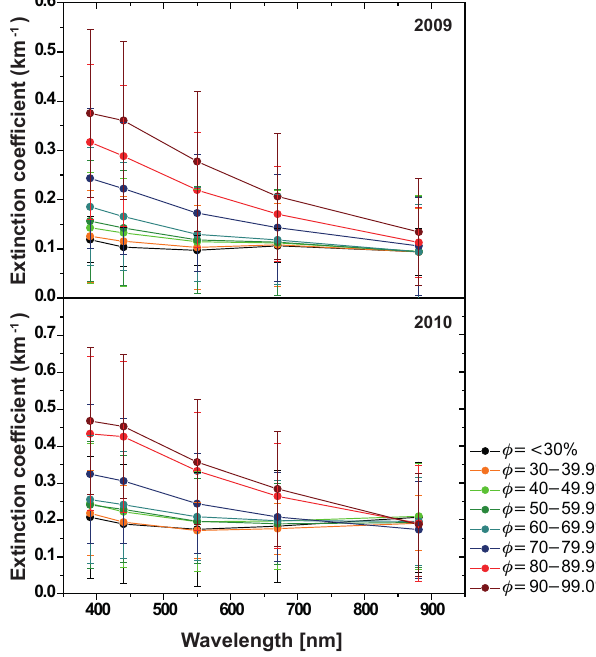
Figure 12. The mean extinction coefficient spectrum for eight rel- ative humidity classes (indicated by different colors) for the years 2009 (top) and 2010 (bottom). Vertical bars indicate the SD for each of the shown five extinction coefficients (for five wavelengths) for a given humidity